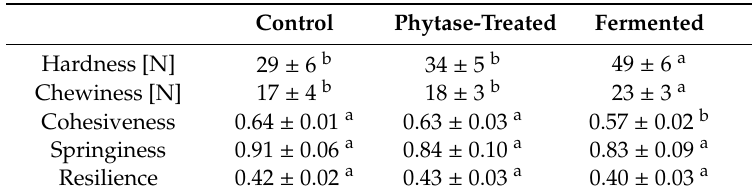
Table 5. Texture profile analysis of the extrudates. Values sharing a letter within a row are not statistically di ff erent. Standard deviations are shown ( n =